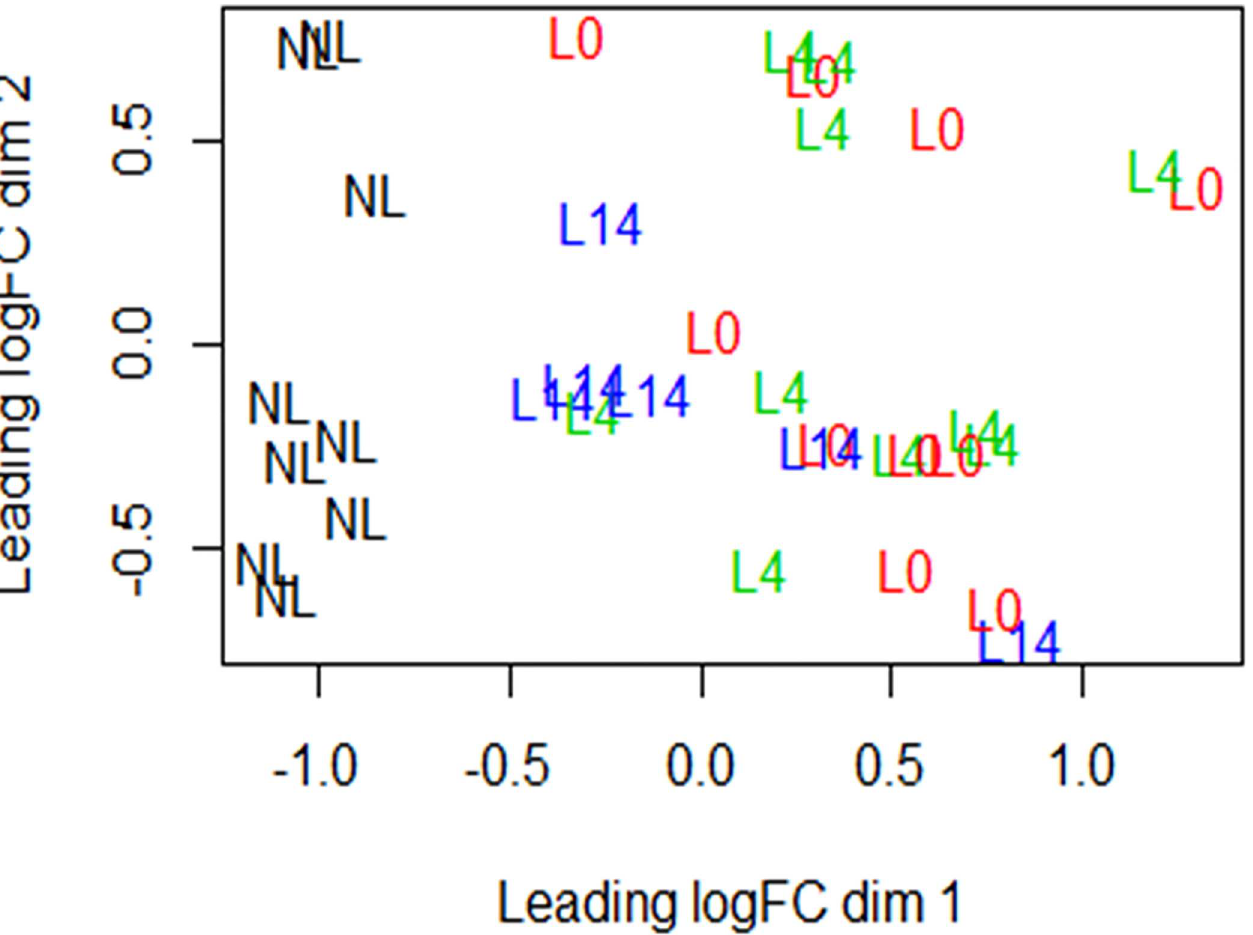
Fig 2. PCA plot of the samples (NL, L0, L4 and L14). The PCA plot shows clear differences betweennonlesionalskin (NL) and lesionaluntreated skin (L0). Also lesionalskin 14 days after adalimumab treatment initiation(L14) tends to resemblethe